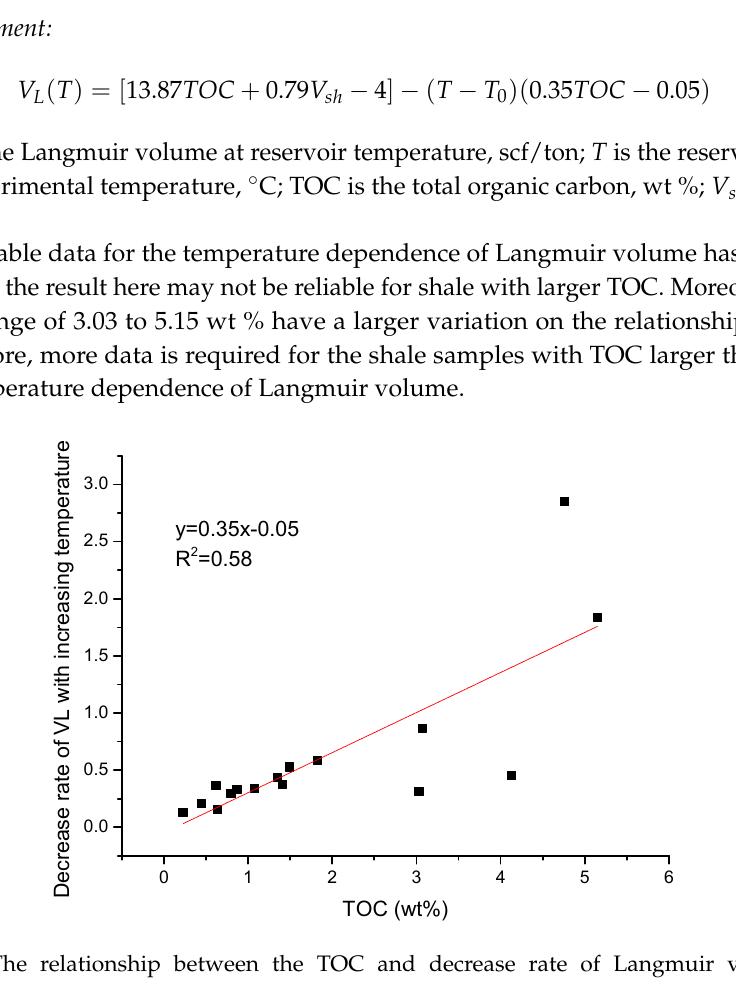
Figure 6. The relationship between the TOC and decrease rate of Langmuir volume with increasing